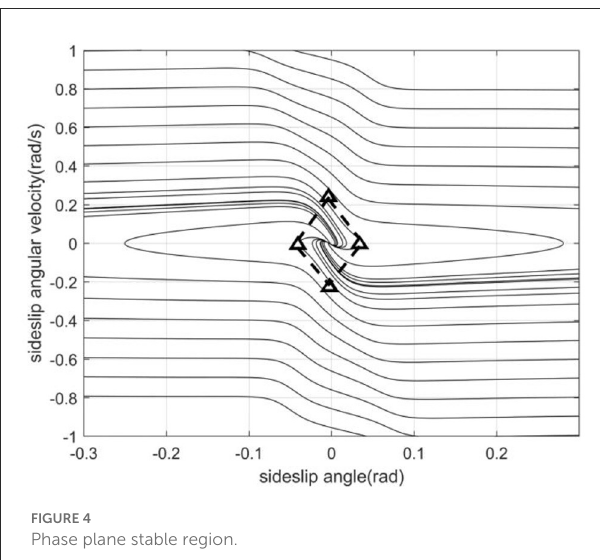
FIGURE4 Phase plane stable region.